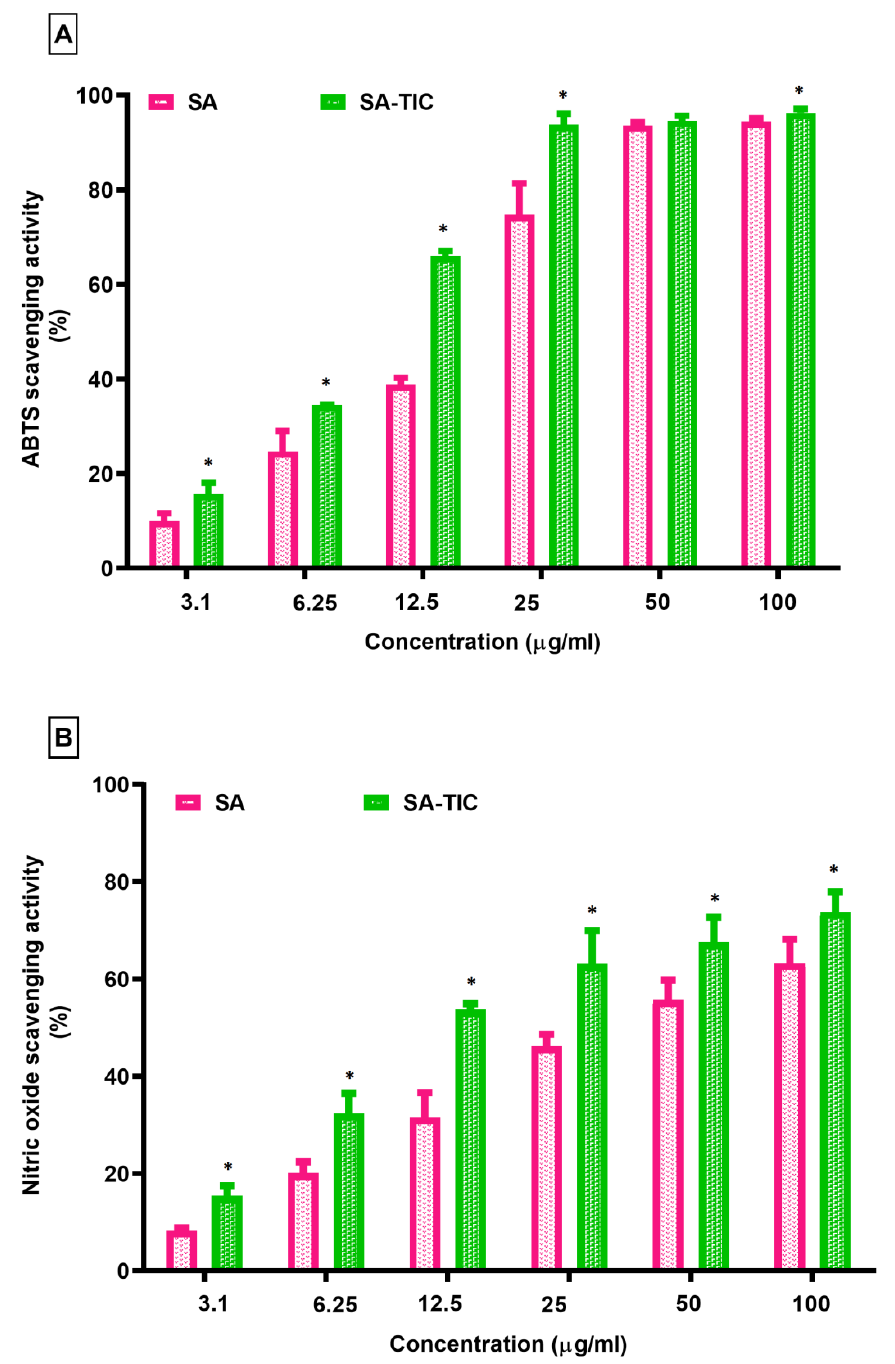
Figure 7. ( A ) ABTS and ( B ) nitric oxide scavenging activity of SA and TIC, * p < 0.05, as compared to